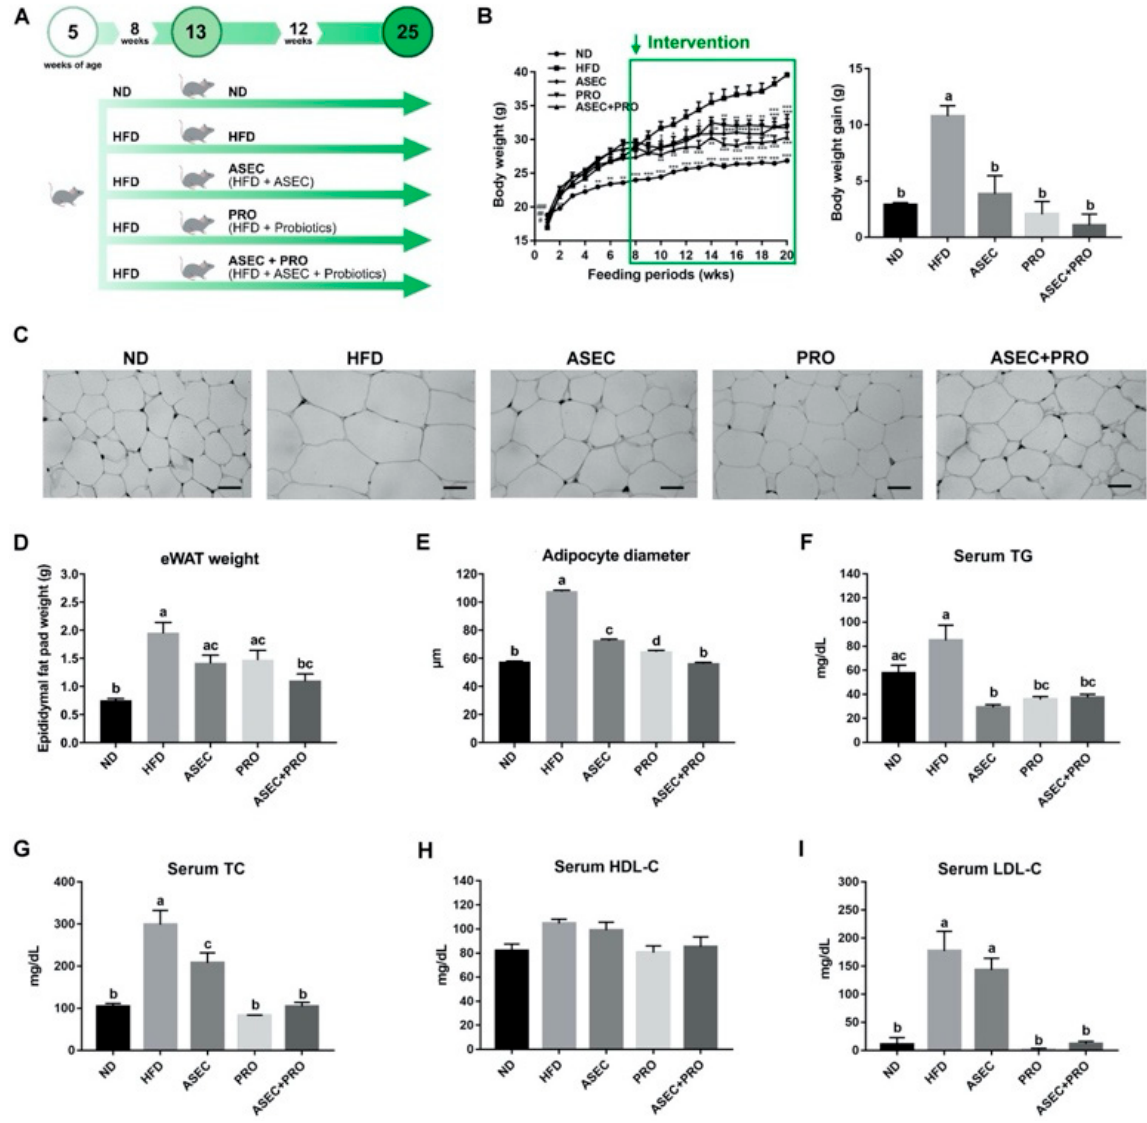
Figure 1. Intervention with ASEC, PRO, or ASEC + PRO improved body weight gain, fat deposition, and dyslipidemia in HFD-induced obese mice. ( A ) A graphical illustration of the treatment scheme. Male C57BL/6J 5-week-old mice were fed a normal diet (ND) or a high-fat diet (HFD) for 8 weeks before receiving the ASEC, PRO, or ASEC + PRO intervention. ( B ) Changes in body weight over time and the body weight gain at the end time point. The body weight gain was the weight difference between the beginning and the end of the experiment. ( C ) H&E staining of adipocytes in the epididymal white adipose tissue (eWAT). The scale bar indicates 100 µm. ( D ) The weight of eWAT. ( E ) The diameter of adipocytes. ( F ) Serum triglyceride (TG). ( G ) Serum total cholesterol (TC). ( H ) Serum high-density lipoprotein cholesterol (HDL-C). ( I ) Serum low-density lipoprotein cholesterol (LDL-C). Data ( n = 8) are expressed as the mean ± SEM. ASEC, adlay seed extrusion-cooked prebiotic; PRO, probiotics. Statistical significance ( p < 0.05) is indicated by different letters (e.g., a, b). * p < 0.05, ** p < 0.01, *** p <